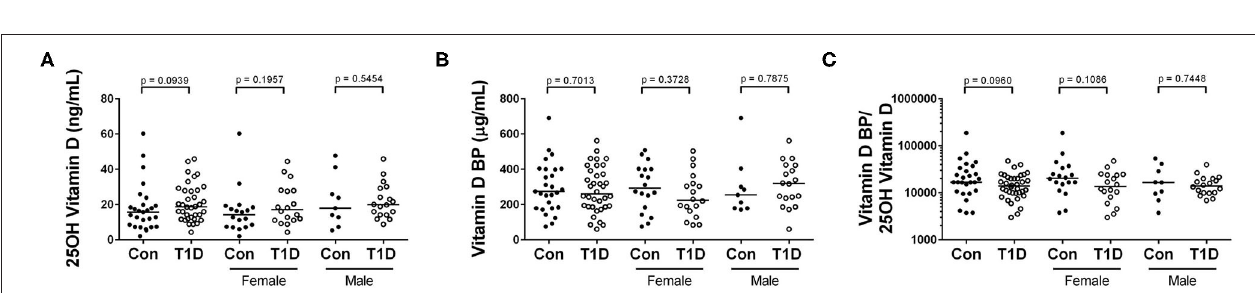
FIGURE 4 | Elevated sCD14 and FABP2 in T1D subjects, and heightened CRP among female T1D subjects. (A) We observed significantly heightened sCD14 levels among T1D subjects compared to control. (B,C) Lipopolysaccharide binding protein (LBP) and mannose binding lectin (MBL) were relatively similar between the two groups and revealed no significant differences. (D) C reactive protein (CRP) levels were relatively similar when comparing total T1D subjects, yet when stratifying by sex, female T1D subjects were significantly elevated in relation to female controls. (E) Fatty acid binding protein 2 (FABP2) levels were significantly elevated in T1D subjects. Bars represent median values.